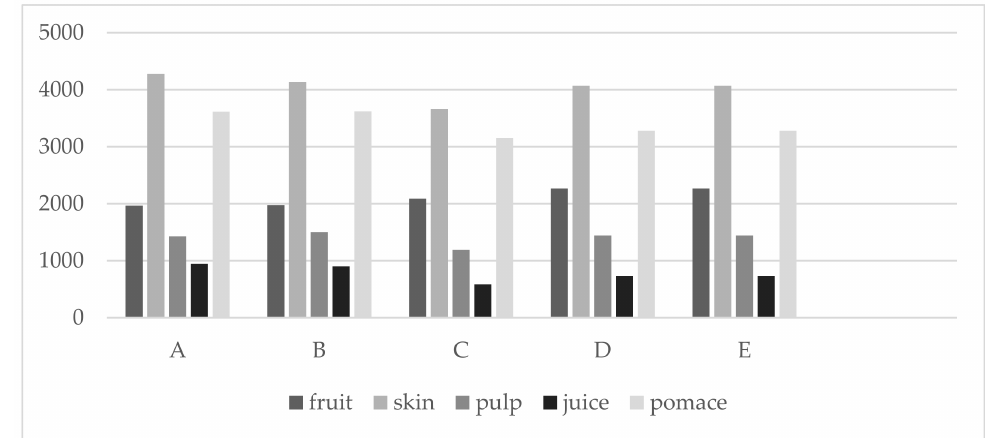
Figure 1. Total phenolic content (mg/kg) in different part of the fruits collected from different villages (A) Adjara, (B) Dandalo, (C) Merisi, (D) Shuakehevi and (E) Khulo.